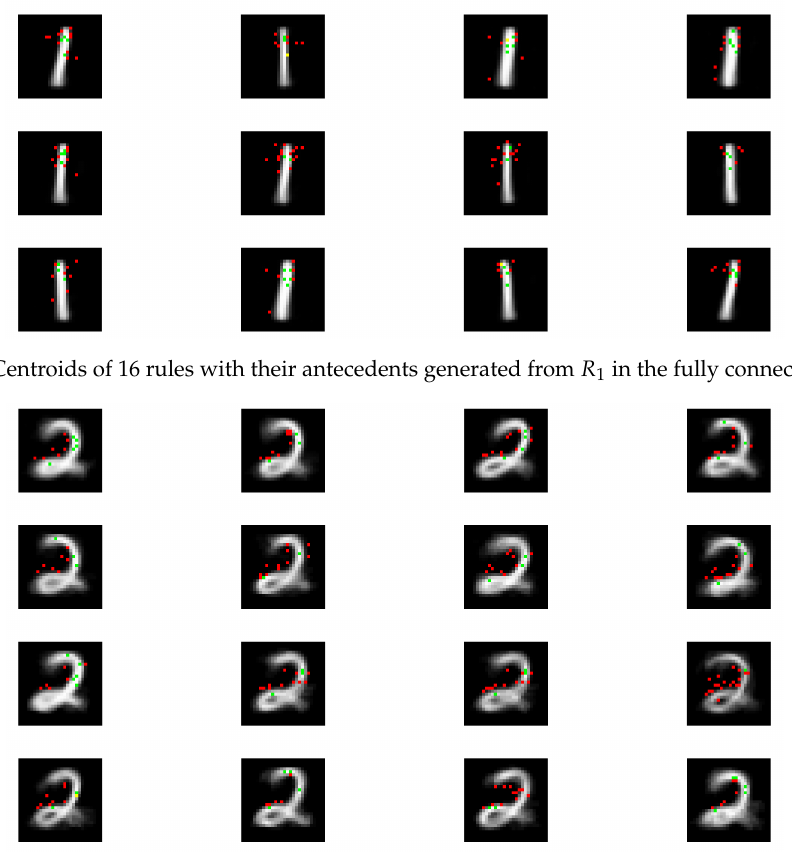
Figure 5. Centroids of 16 rules with their antecedents generated from R 131 in the fully connected layers.